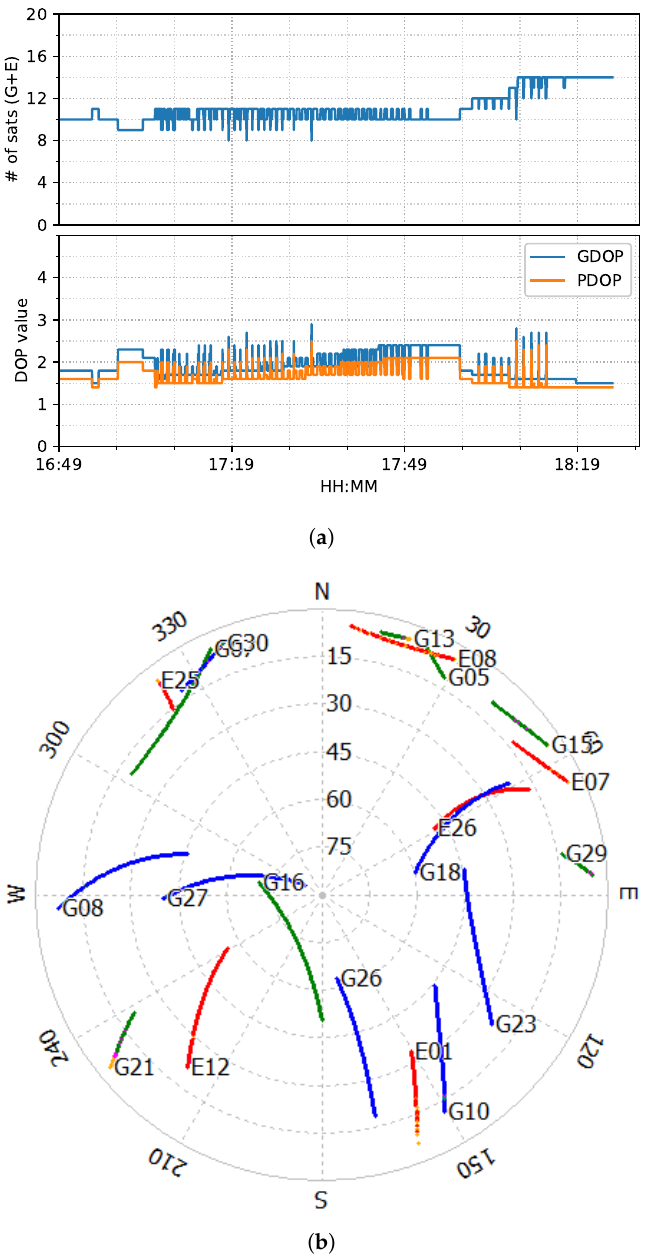
Figure 6. GPS/Galileo satellite information (elevation angle above 10 degrees) of train test on 7 March 2022. ( a ) Number of satellites and DOP values. ( b ) Skyplot. (Different color stands for the availability of different frequencies, generated by RTKLIB